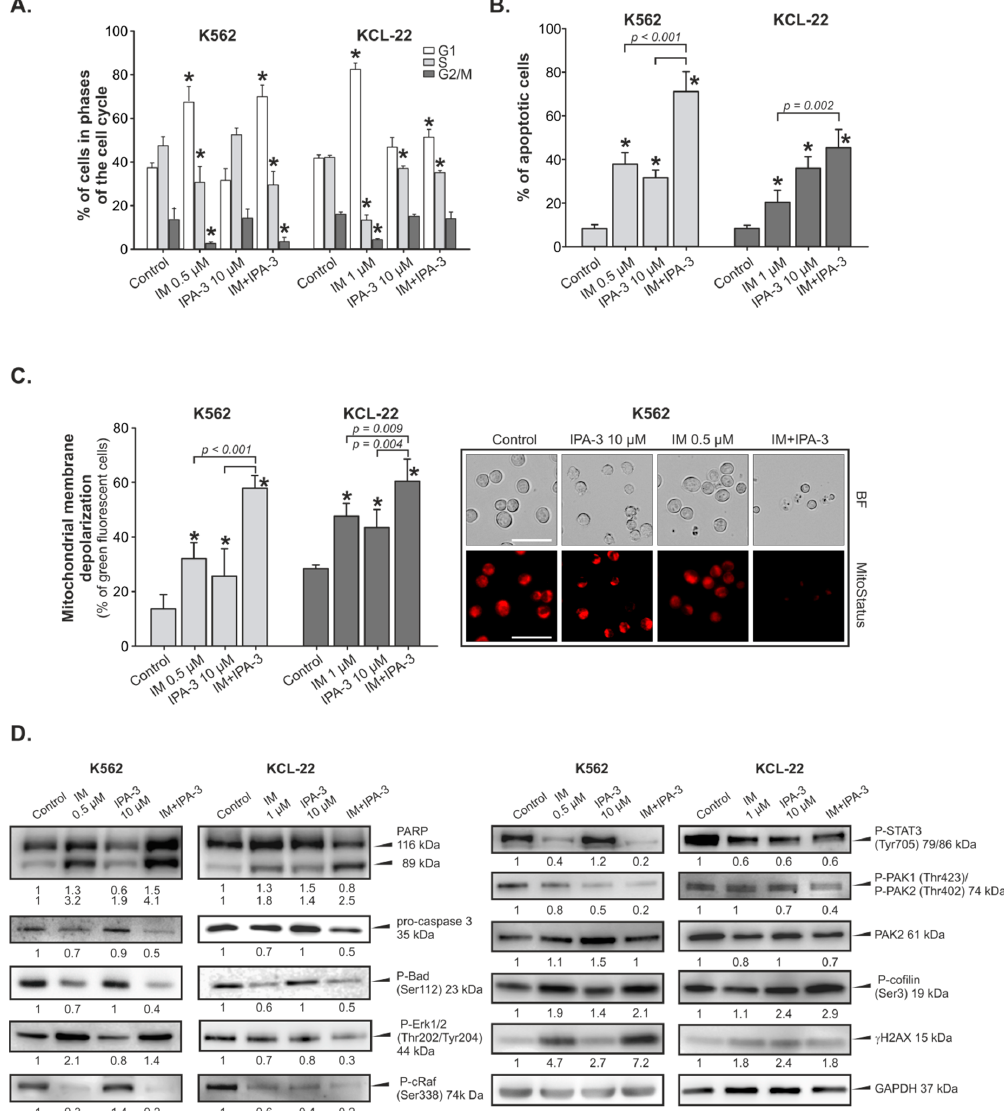
Figure 2. Effect of imatinib (IM), IPA-3, and their combination on cellular processes in K562 and KCL-22 cells. ( A ) Changes in the cell cycle distribution of K562 and KCL-22 cells after treatment with the indicated inhibitors. Each bar represents the mean ± SD. ( n ≥ 4). A significant difference compared with the control group at p ≤ 0.003 is indicated by an asterisk (*). ( B ) Detection of apoptosis by using